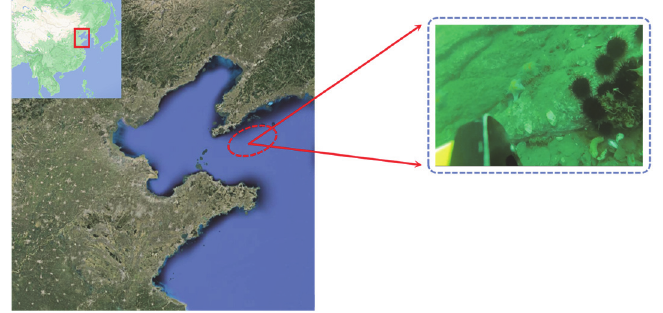
Figure 9. The area where the data are collected.